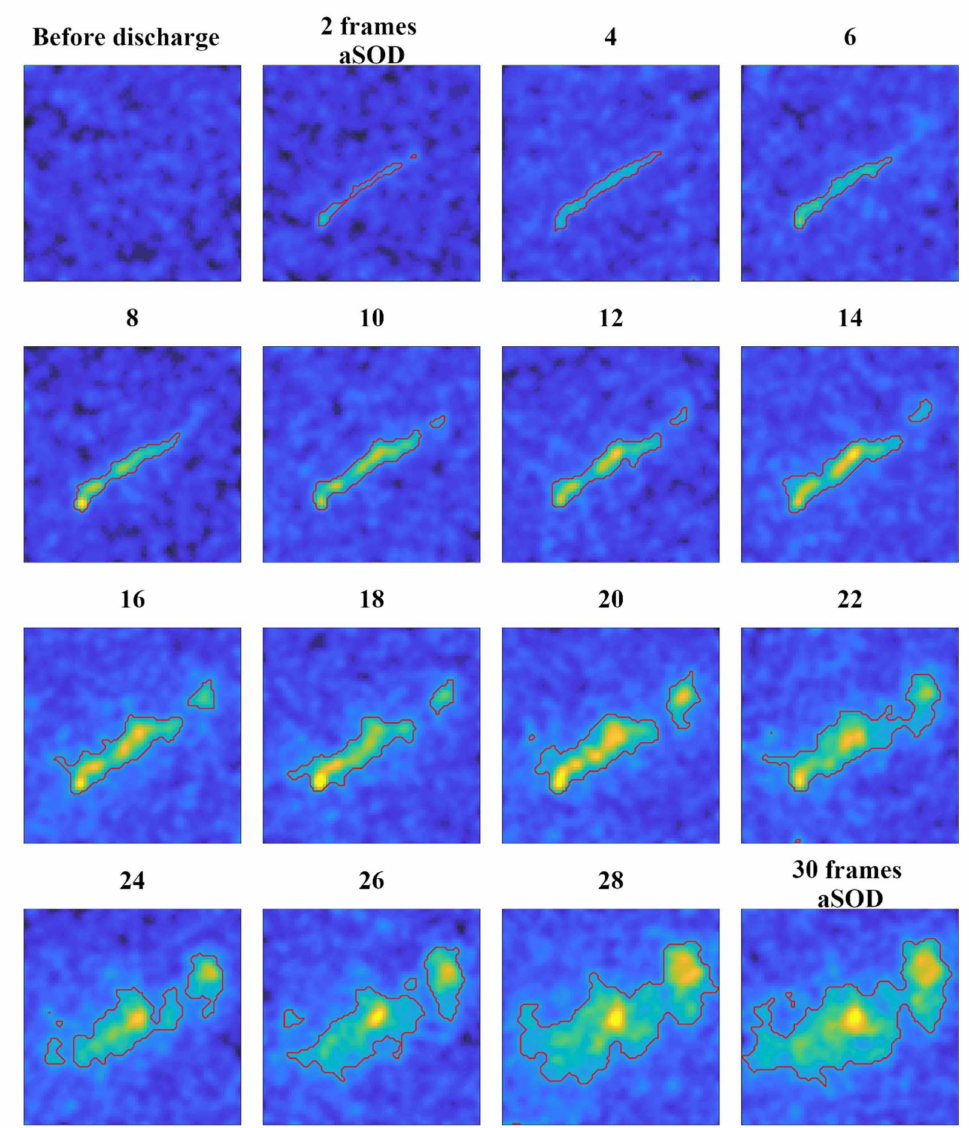
Figure 9. Streamer evolution for λ = 1.0, combustion #2, first quadrant. The igniter is in the bottom-left corner. The numbers above each picture refer to the corresponding frames from the start of discharge. Streamer-to-flame transition occurs at the 14th frame after the start of discharge, according to the method presented in this